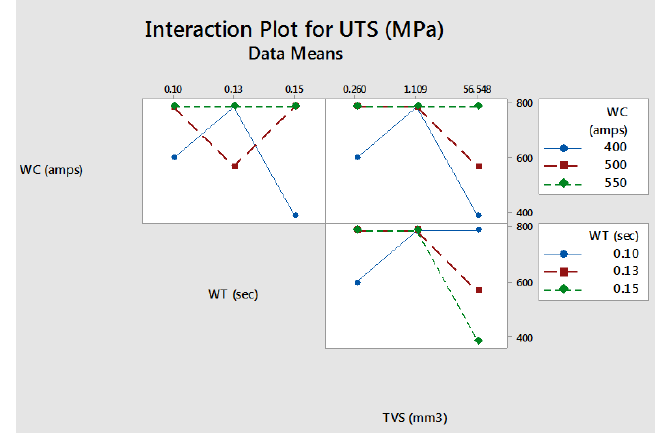
Figure 11. Interaction plot for ultimate tensile strength.